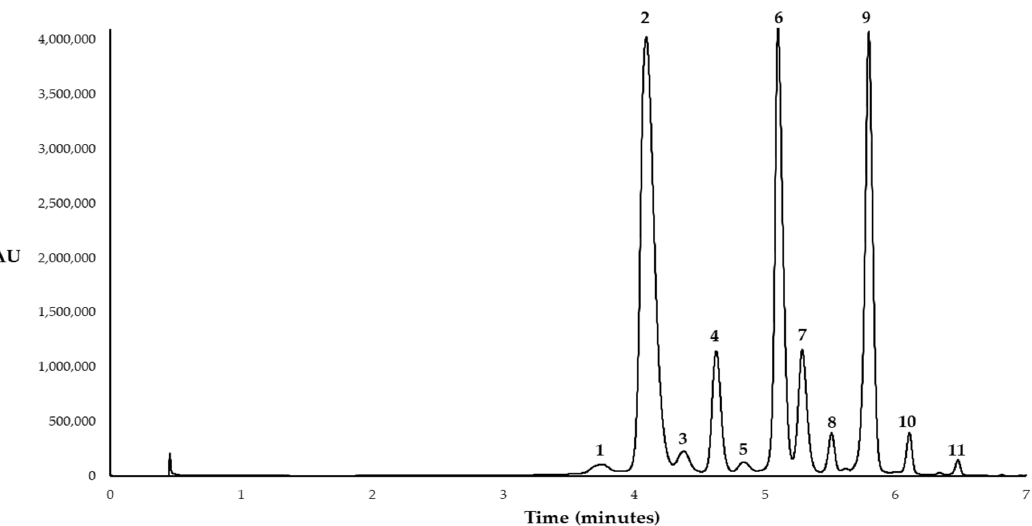
Figure 8. Chromatogram of the 11 anthocyanins identified in the UAE extracts from myrtle